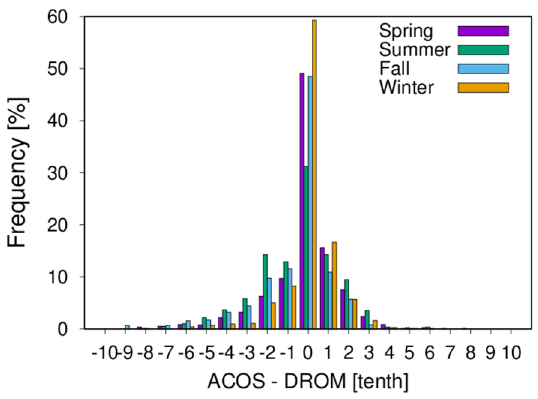
Figure 8. Difference frequency distribution of DROM and ACOS by cloud cover for each season in 2019. Table 3. Agreement frequency (%) according to the seasonal and annual cloud cover difference (Diff.) between ACOS and DROM in 2019.